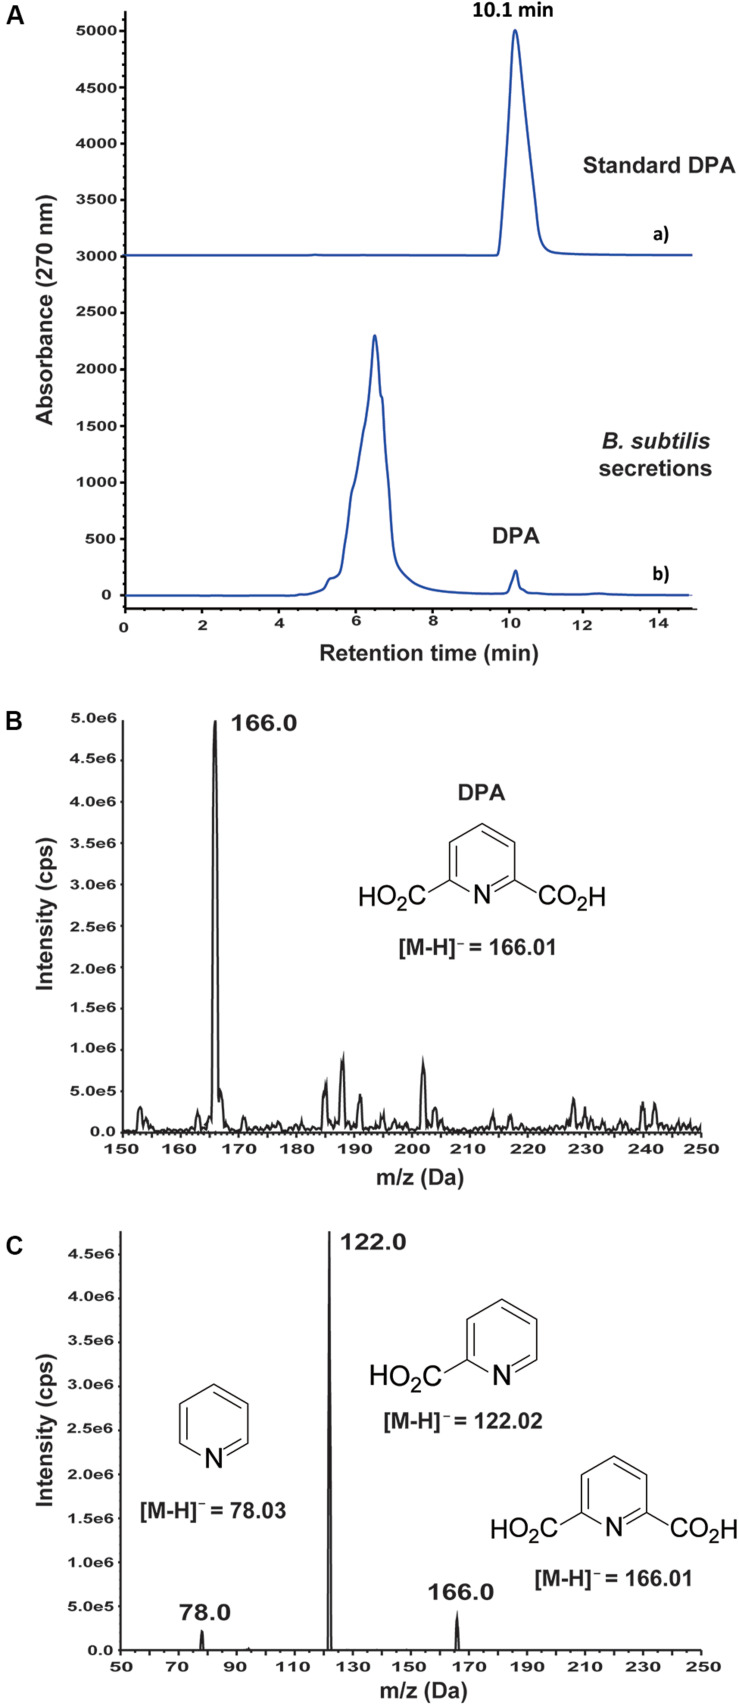
Detection and identification of dipicolinic acid (DPA) in the secretions of wild-type Bacillus subtilis 168. (A) (a) Standard DPA; (b) HPLC-based study of B. subtilis 168 secreted metabolites. DPA was detected at 0.24 ± 0.01 mM concentration after growing B. subtilis 168 for 72 h in LB medium. (B) MS analysis of B. subtilis 168-secreted DPA. (C) MS/MS analysis of the m/z peak at 166.0 Da.